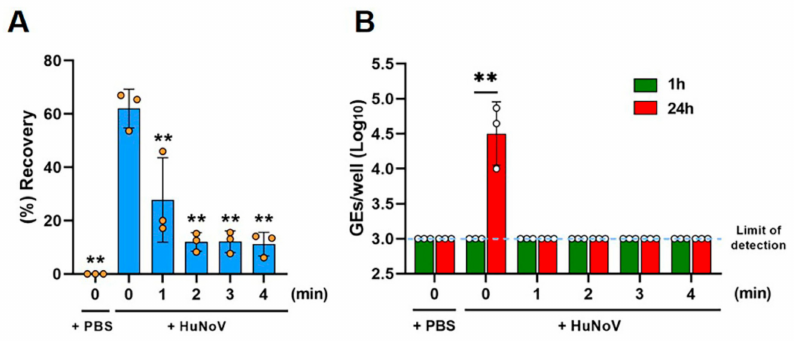
Figure 2. Thermal inactivation of HuNoV in freshwater clams. The clam tissue was spiked with either PBS or HuNoV-containing stool filtrate. The spiked clam tissue was next left untreated or heat-treated at 90 ◦ C for 1, 2, 3, or 4 min and then homogenized. ( A ) Viral GEs in the clam extracts were quantified by RT-qPCR, and the recovery efficiency was calculated as in the Materials and Methods. ** p < 0.01 vs. unheated HuNoV-spiked clam samples (0 min), one-way ANOVA followed by Dunnett’s multiple comparison test. ( B ) The samples were inoculated against differentiated HIEs, and HuNoV GEs in the HIEs were determined as in the Materials and Methods. The limit of detection in the RT-qPCR analysis is 3.0 log 10 GEs/well. ** p < 0.01, two-tailed Student’s t -test. Results are shown as the mean ± standard the deviation calculated from 3 independent experiments ( n =